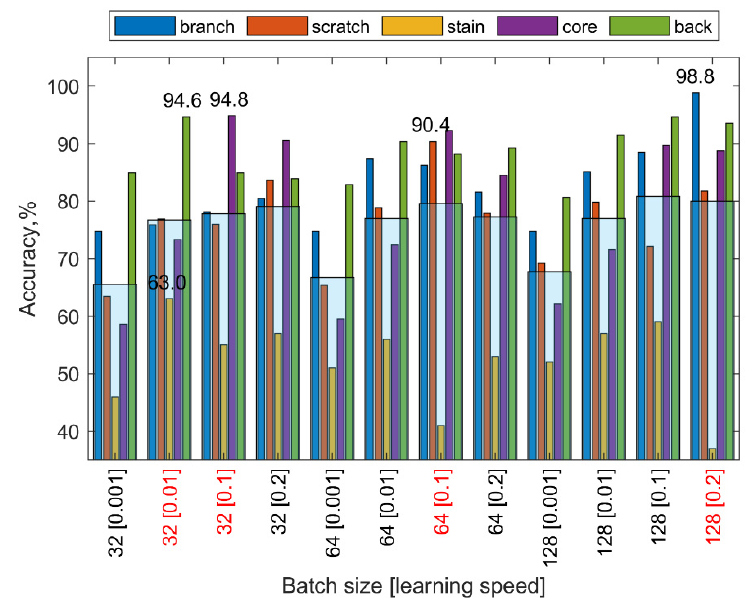
Figure 16. Classification accuracy using ResNet152 neural network trained with different network parameters (batch size and learning speed). The best combinations of parameter values are indicated in red.